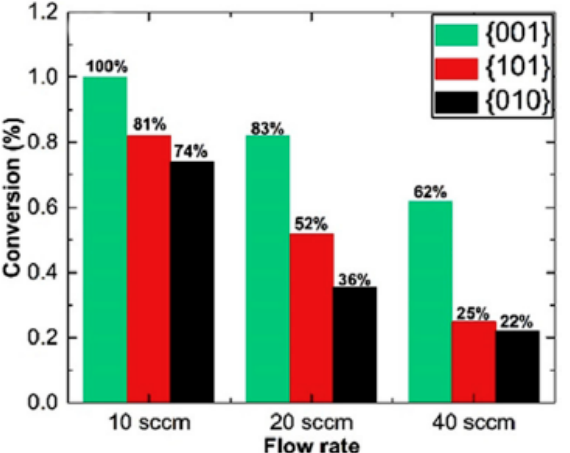
Figure 12. Degradation efficiency of gaseous acetaldehyde at different flow rates under UV/Vis irradiation on anatase type TiO 2 with different dominant faces. Reprinted from [59], Copyright 2020, with permission from Elsevier.